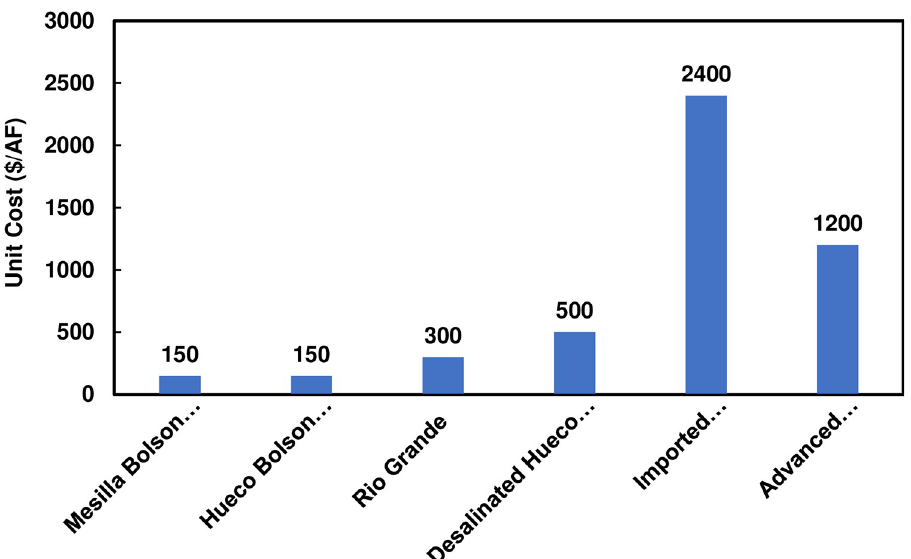
Fig 3. Annualized unit costs for water supply sources used in future supply and demand scenarios. Data source: Lisa Franklin Rosendorf, personal communication, El Paso Water, February 12, 2020. Graphic representation source: Work of the